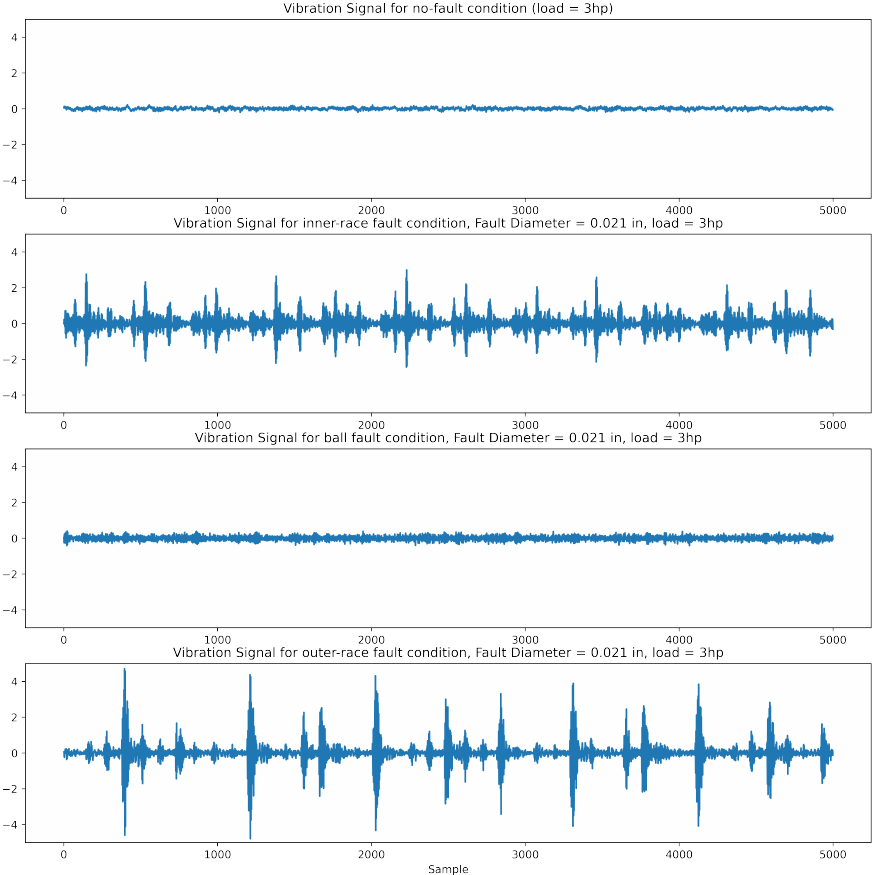
Figure 5. A snapshot of vibration signal in normal and faulty